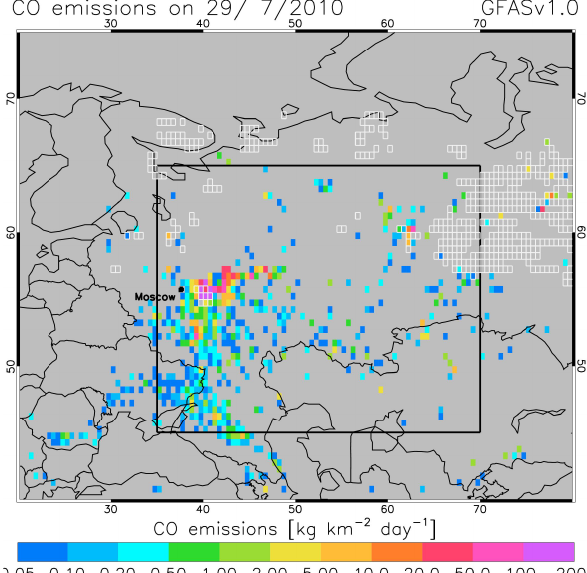
Fig. 3. Snapshot of CO emissions from GFASv1.0 on 29 July 2010. The white boxes indicate areas with peat soil as the dominant land cover type. Also indicated is the western Russia region (35 ◦ E– 70 ◦ E × 45 ◦ N–65 ◦